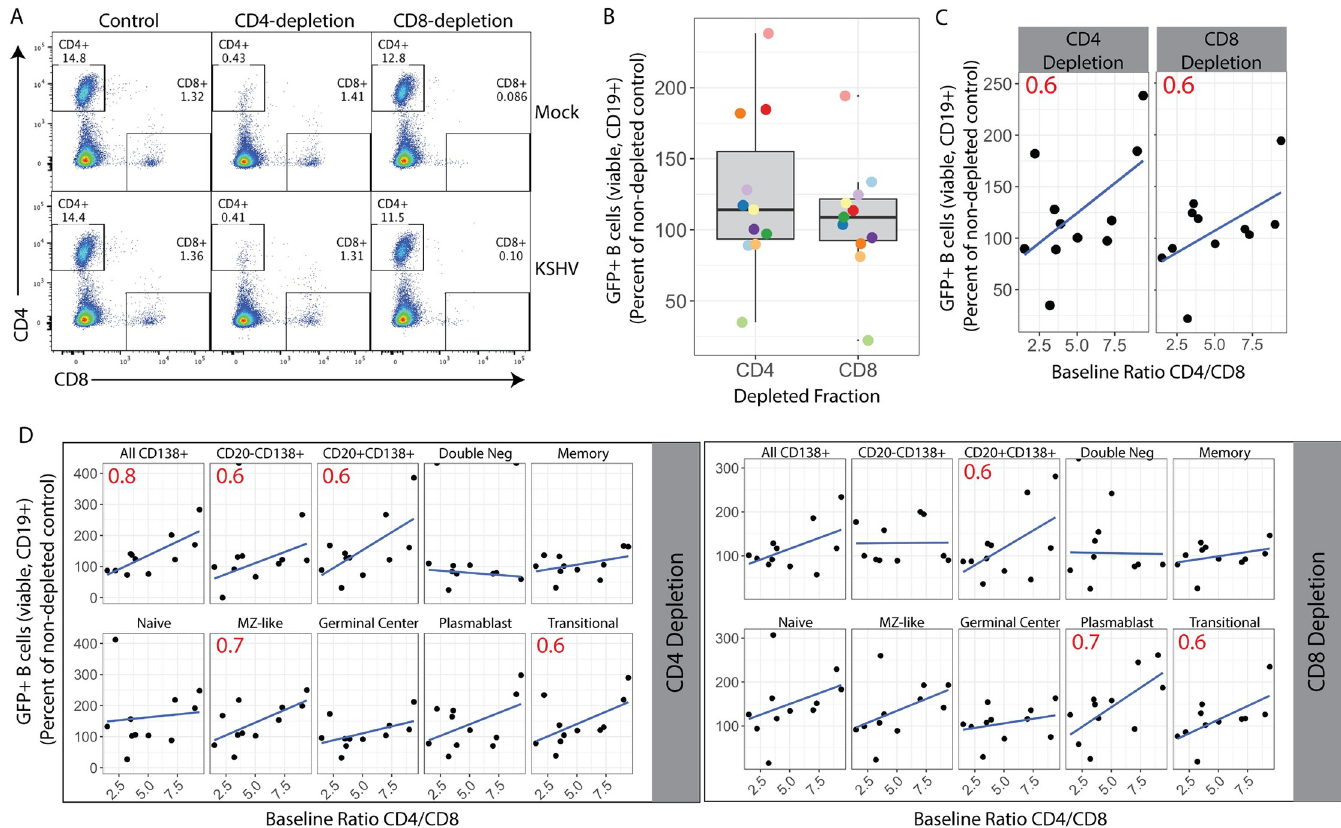
Fig 6. Manipulation of T cell microenvironment alters KSHV tropism for B cell lineages. Na ï ve B lymphocytes from 11 human tonsil specimens were infected with KSHV.219 as in Fig 2A, total lymphocytes added back following infection were either untreated or depleted of CD4+ or CD8+ T cells. At 3 days post-infection cells were collected. (A) T cell depletions were validated by flow cytometry and (B) Cells were stained for B cell lineages as shown in S1A Fig and Table 2 and analyzed flow cytometry for lineage frequencies and KSHV infection by GFP reporter expression to determine the change in GFP+ B lymphocytes (viable, CD19+) in CD4 or CD8 depleted samples compared to non-depleted controls. Colors indicate individual tonsil specimens (n = 11). Student’s T test reveals no statistically significant change in GFP+ B cell frequency between either CD4-depleted or CD8-depleted and non-depleted controls. (C) infection data for T cell depletion studies as in (A) plotted against the baseline (pre-infection) CD4/CD8 T cell ratio in the sample. (D) within-lineage infection frequency plotted against baseline (pre-infection) CD4/CD8 T cell ratio. For B and C linear regression of the data is shown as a blue line and Pearson correlation coefficients (r) are shown as red text within panels only for r with an absolute value � 0.6. Statistical power analysis indicates that this dataset can predict correlations at the level of r > |0.7| with alpha = 0.05 and power = 0.8. Thus, r values � 0.7 can be considered a statistically significant correlation for this data.